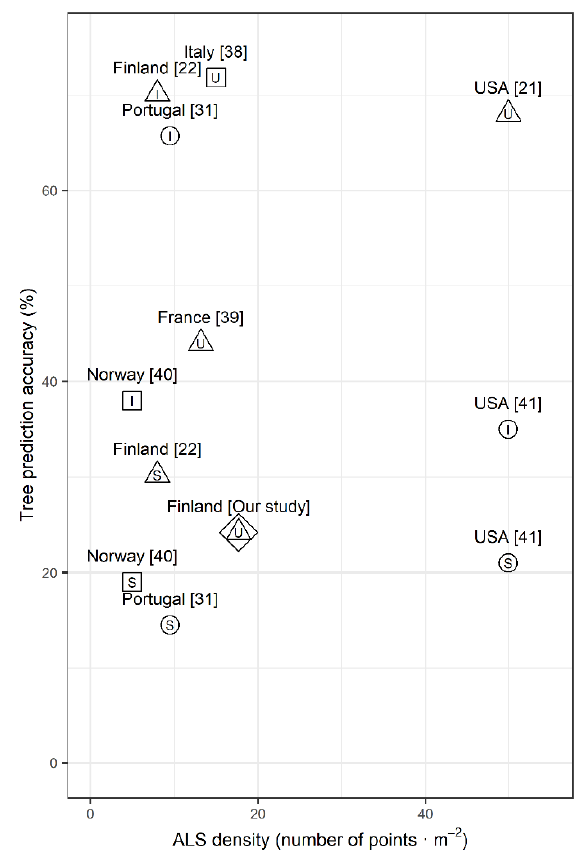
Figure 5. Tree prediction accuracy, and average airborne laser scanning (ALS) point density as reported in various countries. Symbols: I, intermediate trees; S, suppressed trees; U, understory trees; square, coniferous forest; circle, deciduous forest; triangle, coniferous and deciduous forest; rhombus, our study.